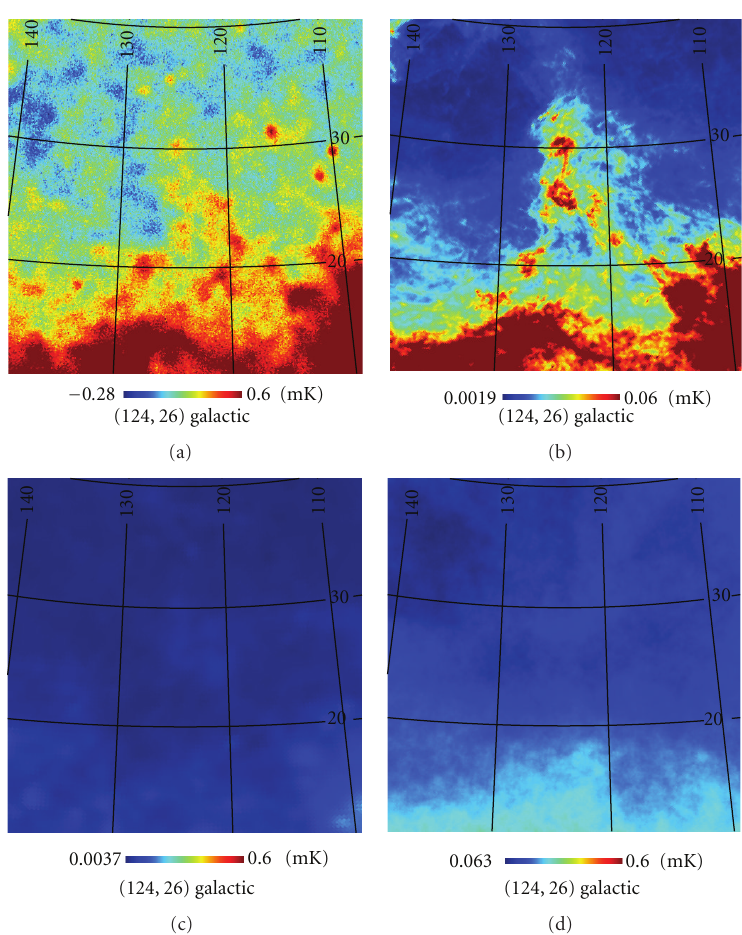
Figure 1: Maps of the region of interest. WMAP K band (a), 94GHz dust prediction (b, [23]). free-free (c) and synchrotron (d) predictions at 23GHz based on the H α map ([21]) and the 408MHz map ([20]) assuming a spectral index β s = − 2 . 9.